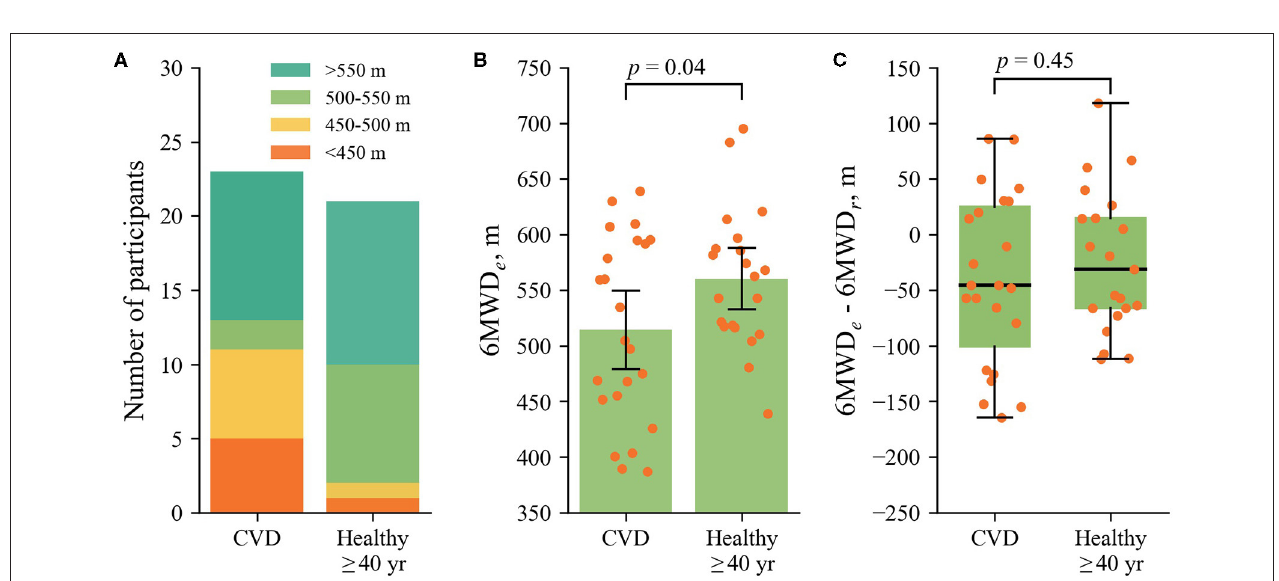
Frontiers in Physiology |